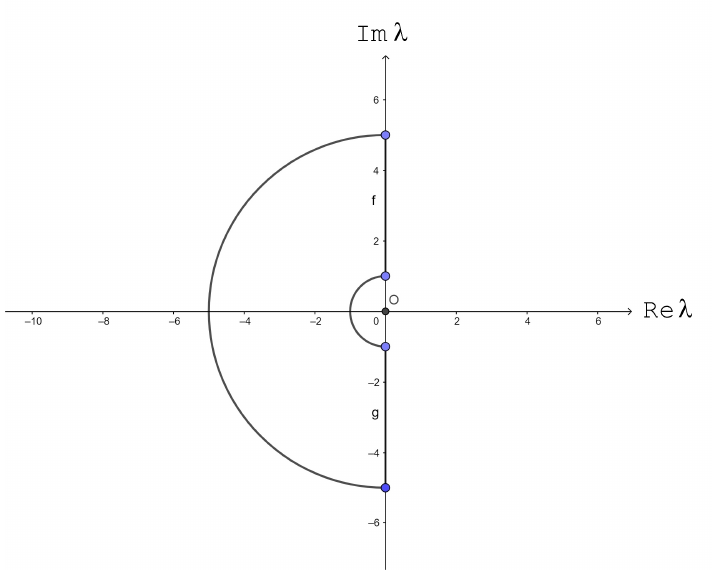
Figure 2. Path of γ curve enclosing all eigenvalues for a stable